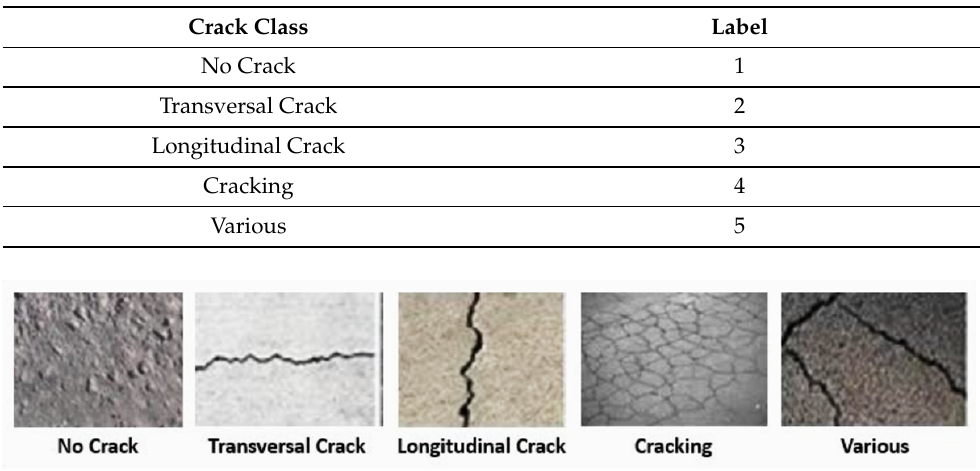
Figure 16. An example of a crack for each